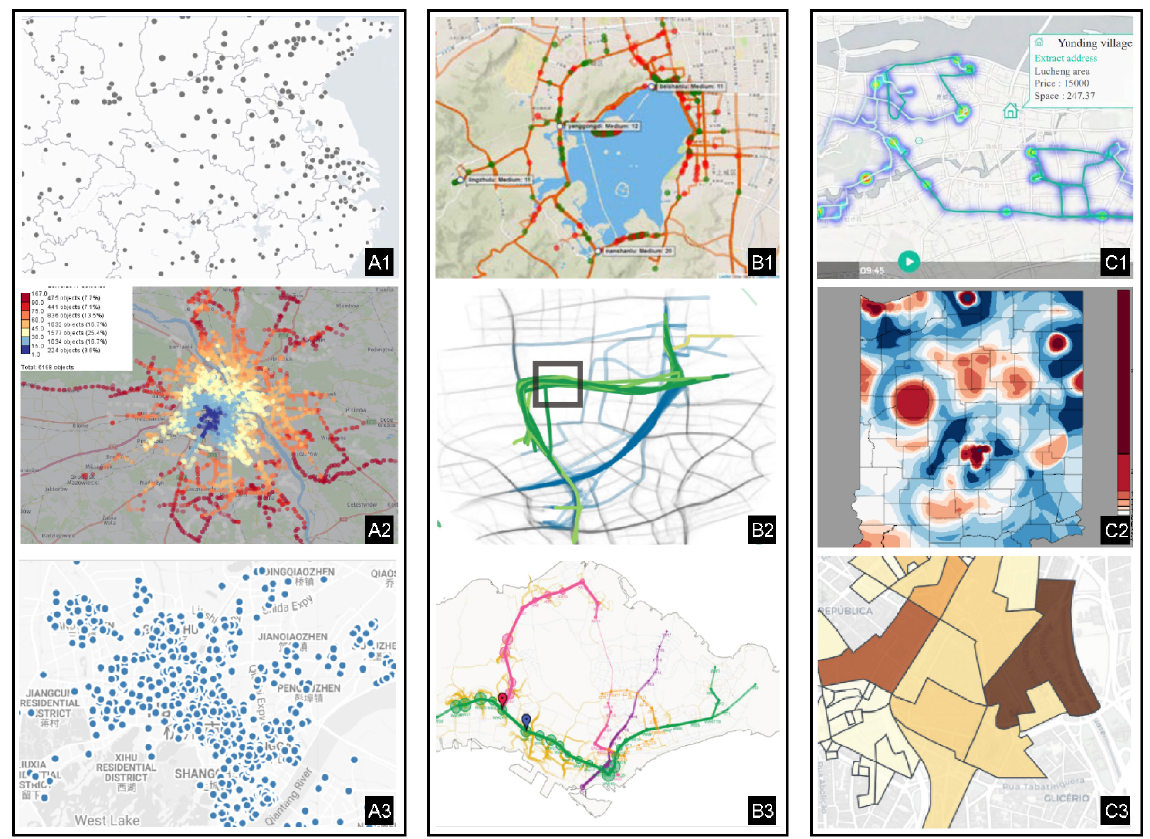
Fig. 1 (A) Examples of dot-on-the-map visualization. (B) Examples of line-on-the-map visualization. (C) Examples of heatmap visualization. Reproduced with permission from Ref. [65] for (A1), c (cid:13) IEEE 2021; Ref. [66] for (A2), c (cid:13) IEEE 2019; Ref. [99] for (A3), c (cid:13) IEEE 2018; Ref. [47] for (B1), c (cid:13) IEEE 2016; Ref. [18] for (B2), c (cid:13) IEEE 2011; Ref. [35] for (B3), c (cid:13) The Authors 2015; Ref. [29] for (C1), c (cid:13) IEEE 2017; Ref. [106] for (C2), c (cid:13) IEEE 2010; Ref. [108] for (C3), c (cid:13) IEEE